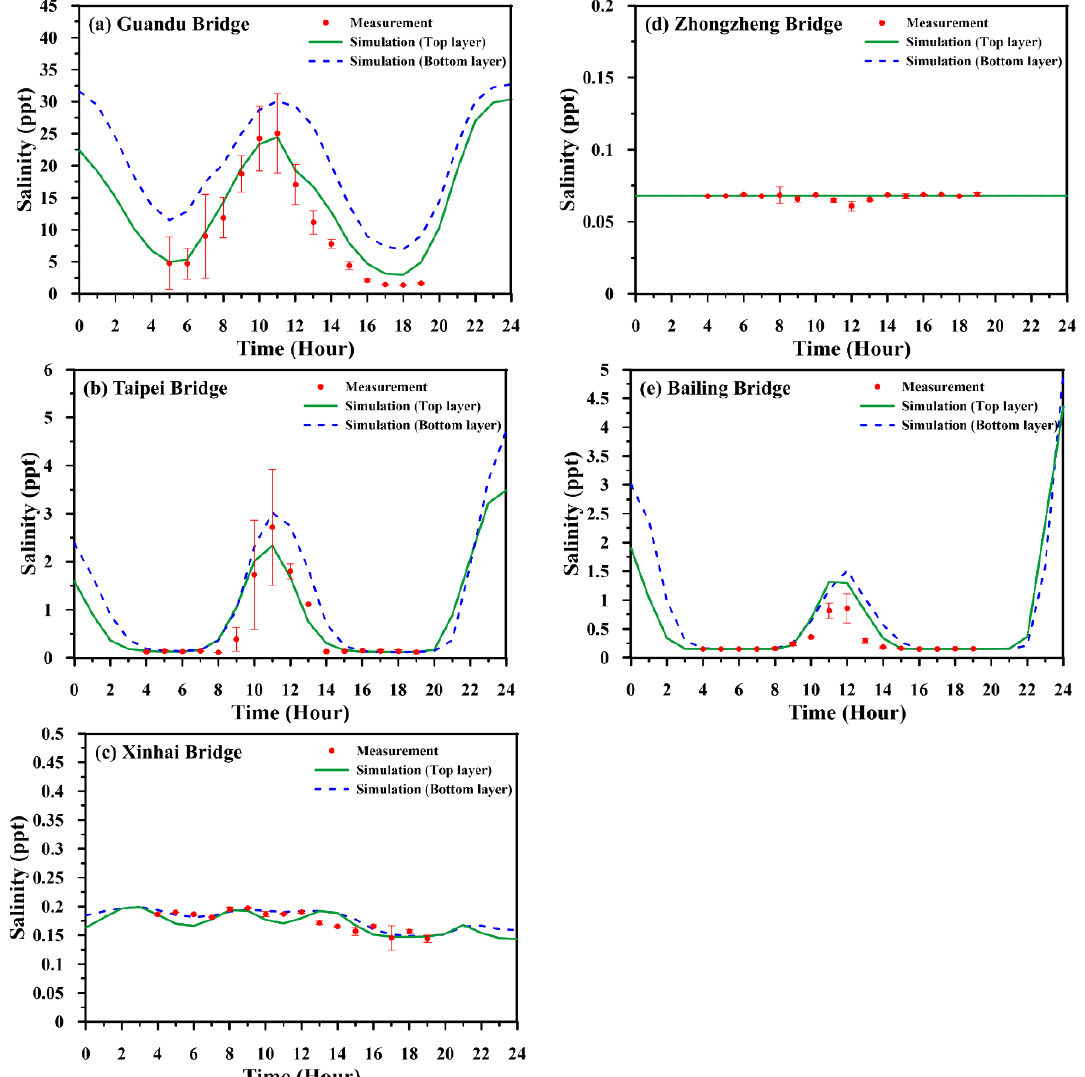
Figure 5. Comparisons of the simulated and measured salinities on 24 June 2017 at the ( a ) Guandu Bridge, ( b ) Taipei Bridge, ( c ) Xinhai Bridge, ( d ) Zhongzheng Bridge, and ( e ) Bailing Bridge.